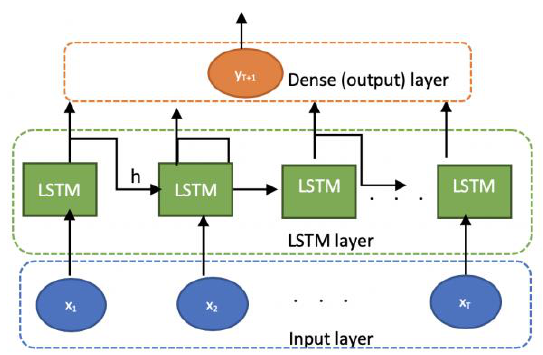
Figure 2. Architecture of applied Long Short-Term Memory (LSTM).